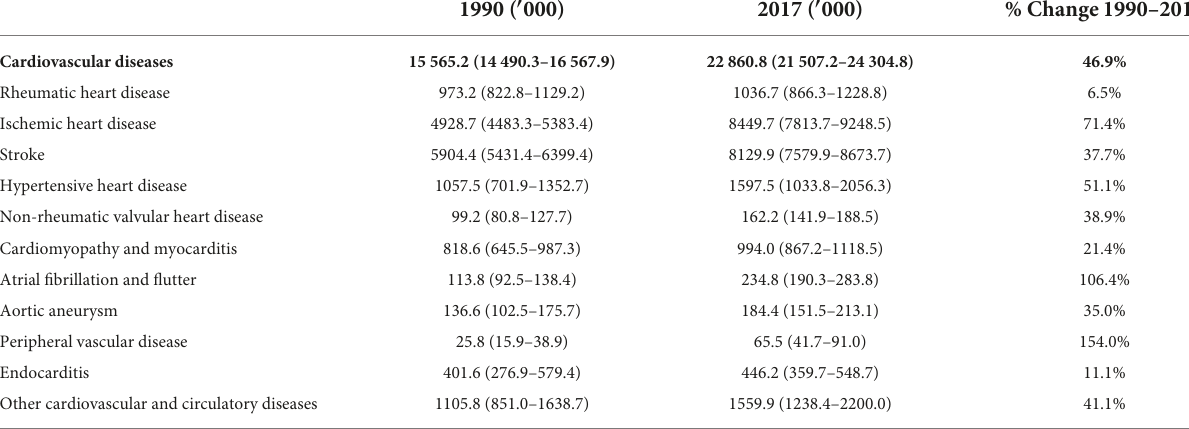
TABLE 1 All-age total DALYs in 1990 and 2017 and percentage change from 1990 to 2017 from CVD in sub-Saharan Africa [GBD]. 1990 ( (cid:48)